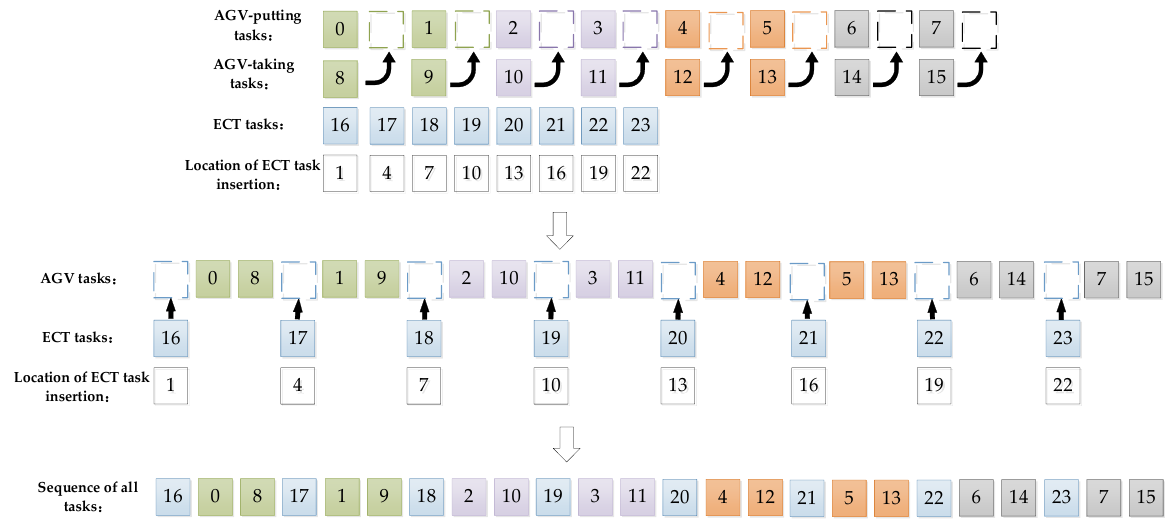
Figure 5. Initial chromosome. corresponds to the sequence of jobs, as shown in Figure 6. The task assignments of the AGV and DCRC for this chromosome are shown in Figure 7.